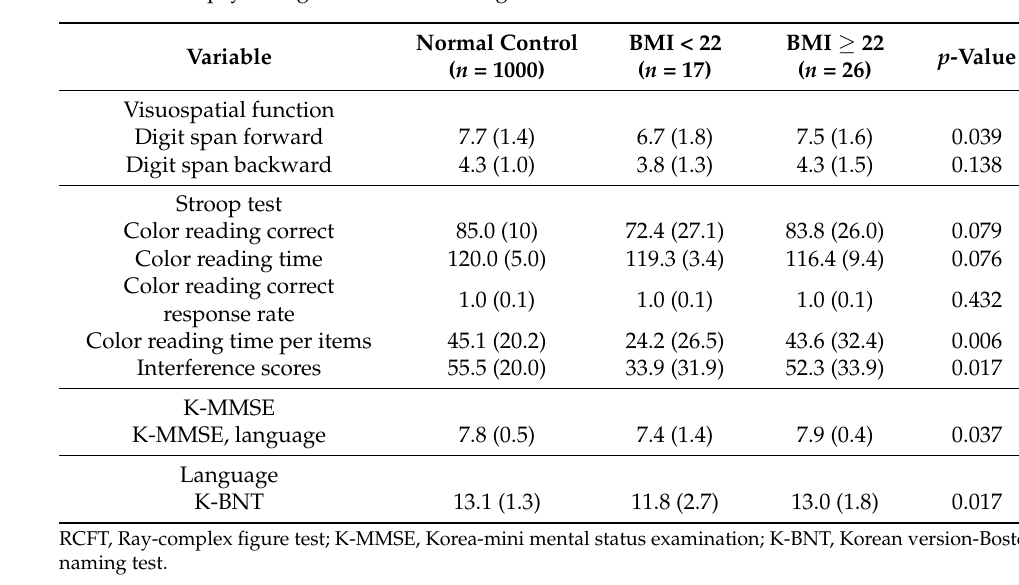
6 of 12 Table 3. Neuropsychological tests related cognitive function. Variable